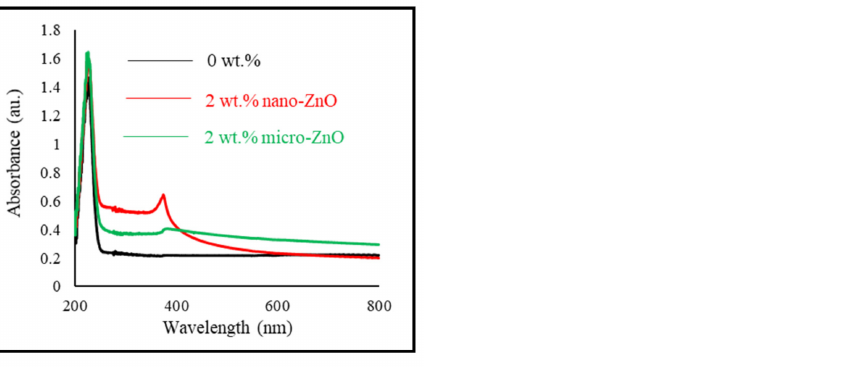
Figure 6. UV–vis spectra of the coatings with (2 wt.%) or without (0 wt.%) ZnO particles.